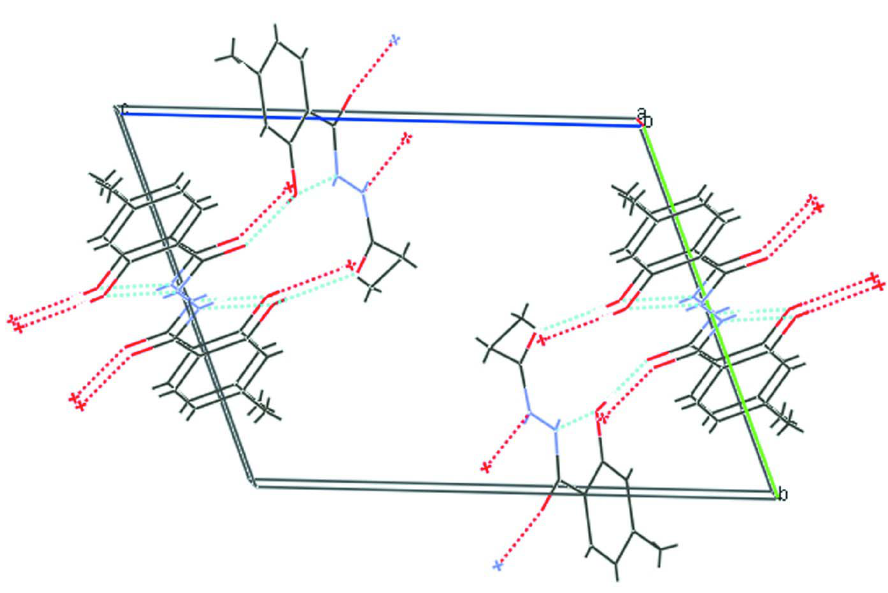
Figure 2 Packing diagram of the title